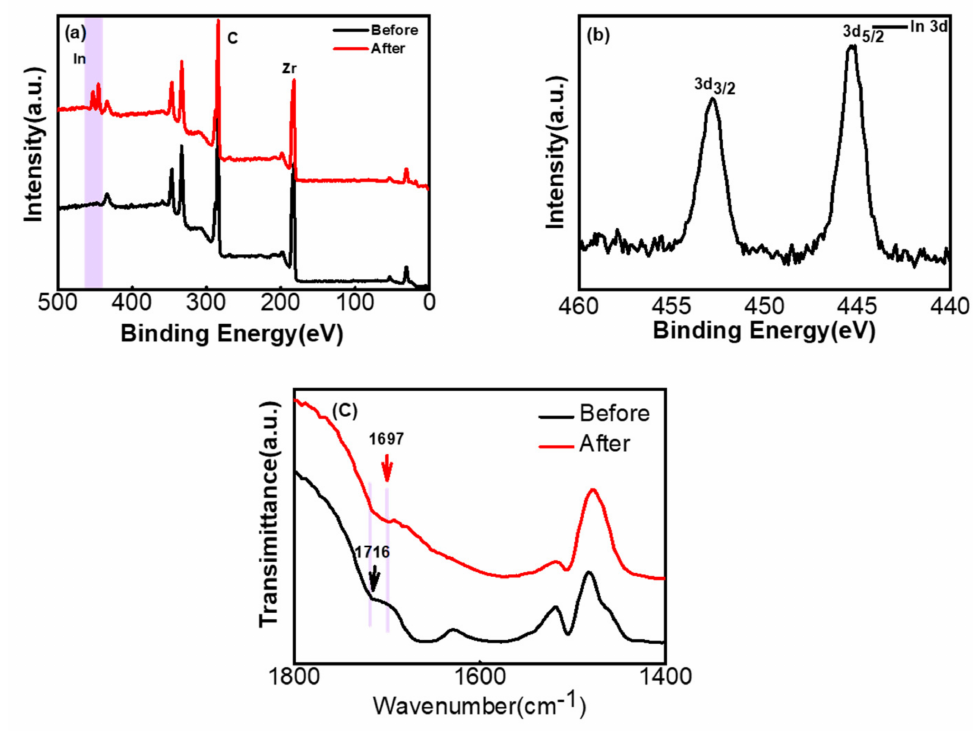
Figure 7. Characterization of UiO-66 before and after In(III) adsorption. ( a ) Wide-scan XPS spectra;